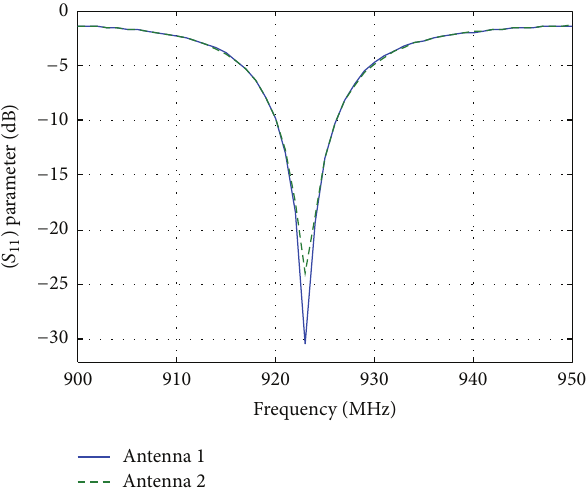
Figure 14: Measured reflection coefficient of fabricated antennas with silver fabric ground plane. Table 2: Measured − 10dB bandwidth of fabricated antennas. Antenna No.